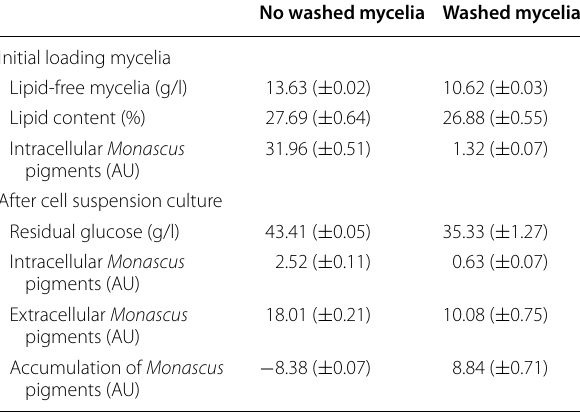
Table 2 Cell suspension culture using before and after washed mycelia as whole cell biocatalyst No washed mycelia Washed mycelia Initial loading mycelia